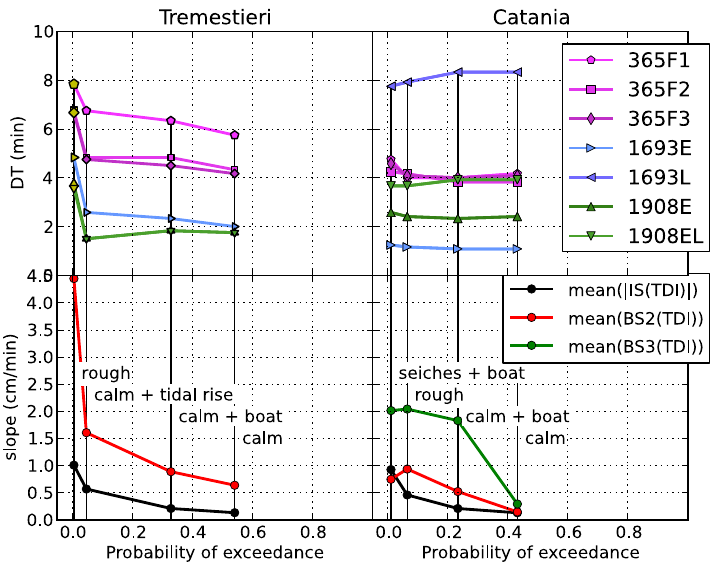
Fig. 11. Delay times (DTs) of TEDA detections (upper panel) given separately for each scenario and mean | IS | and BS values (lower panel) vs. probability of exceedance of | IS | for the four sea-condition windows. Detections made by the TEDA secure-detection method are given with solid yellow